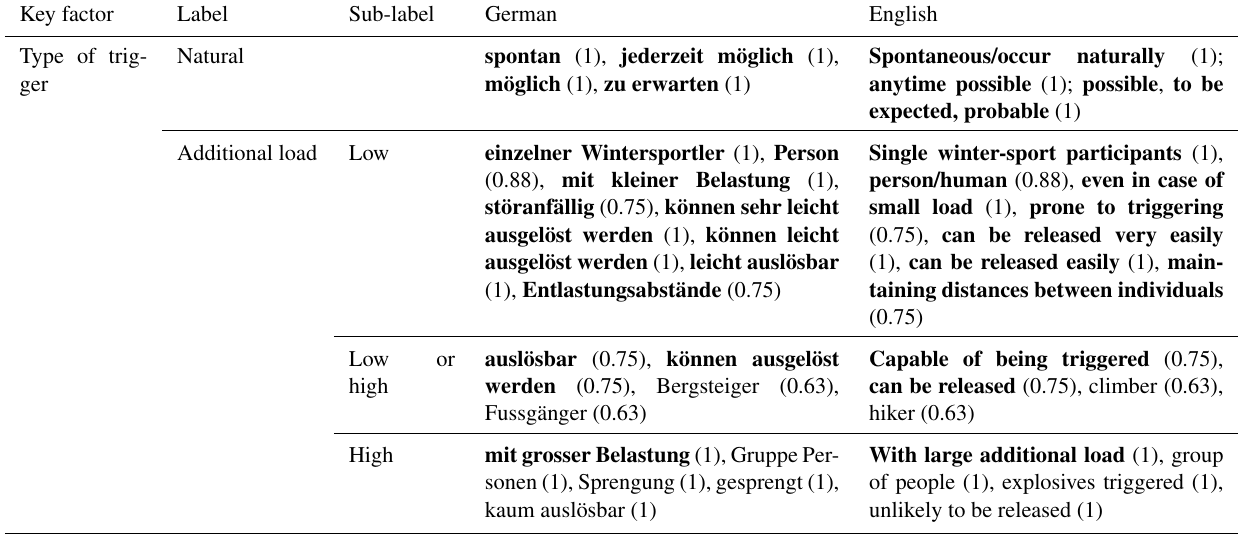
Table A2. Labels assigned to German text values describing the type of trigger (or load) to release an avalanche, including the proportion of forecasters who assigned the respective label–sub-label combination to this value (in brackets) and their corresponding English translations. Note that the proportions shown in the English column are indications only as many-to-one and one-to-many translations were possible (i.e., one English translation for two German words or vice versa). Bold – value was used during the 8 years.